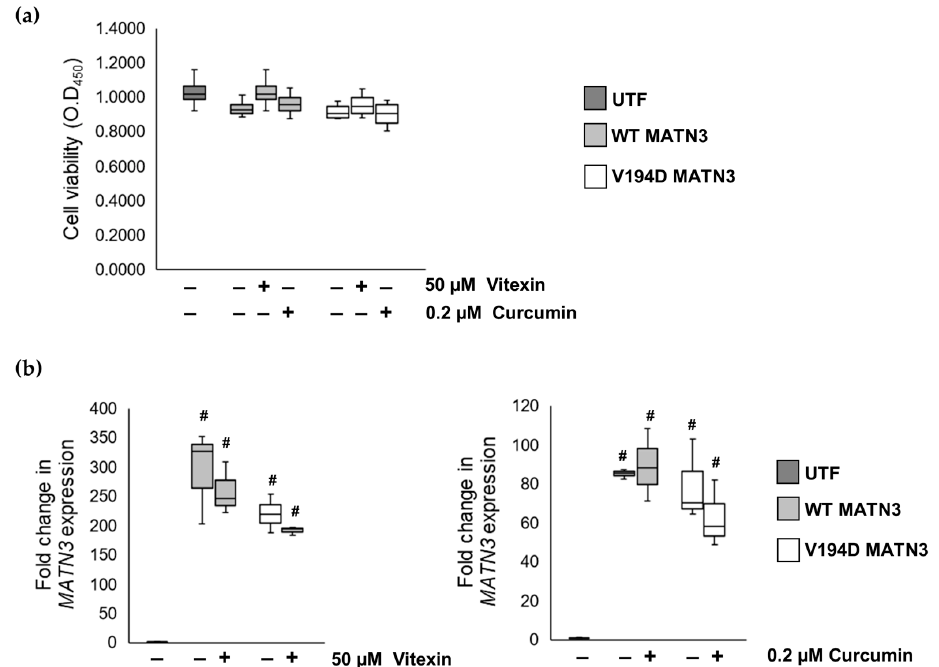
Figure 2. The effects of curcumin and vitexin on reducing pathological ER stress in mutant matrilin-3-expressing cells were independent of reducing both cell viability and MATN3 expression. WT and V194D mutant MATN3-expressing HELA cells were cultured in the presence/absence of either 50 µM vitexin or 0.2 µM curcumin for 48 h. ( a ) To assess if vitexin or curcumin affect cell viability, a WST1 assay is used, as WST1 absorbance is an indicator of cell viability. The administration of vitexin and curcumin to both WT and V194D mutant MATN3-expressing HELA cells does not significantly affect cell viability as absorbance is comparable between treated and untreated cells. ( b ) To determine the effects of treatment on gene expression, the expression level of the gene encoding matrilin-3, MANT3, was measured by qPCR. The administration of vitexin and curcumin to both WT and mutant V194D MATN3-expressing HELA cells does not significantly affect the expression of MATN3. (MATN3: matrilin-3, WT: wild-type, UTF: untransfected, # significant to UTF, n = 3).